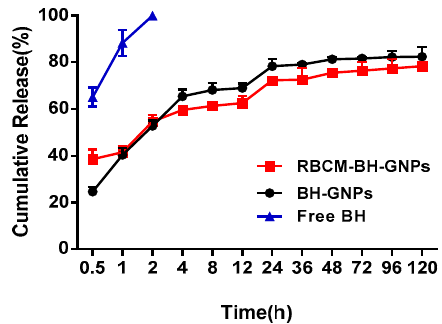
Figure 9. Release profiles of RBGPs and BGPs at 37 °C for 120 h; experiments were repeated independently at least three times.